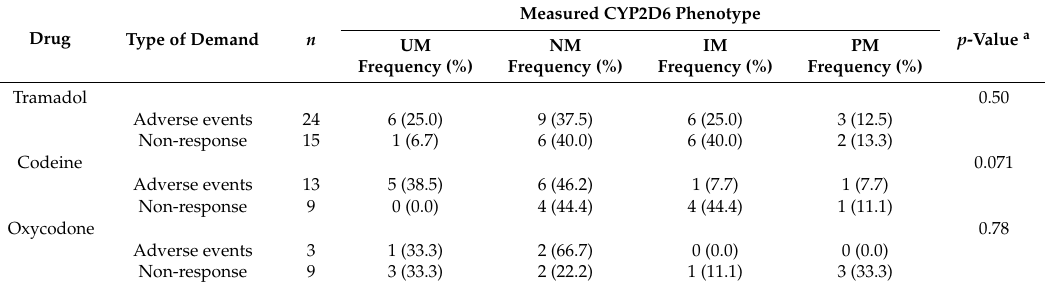
Table 7. Association between the type of demand and measured